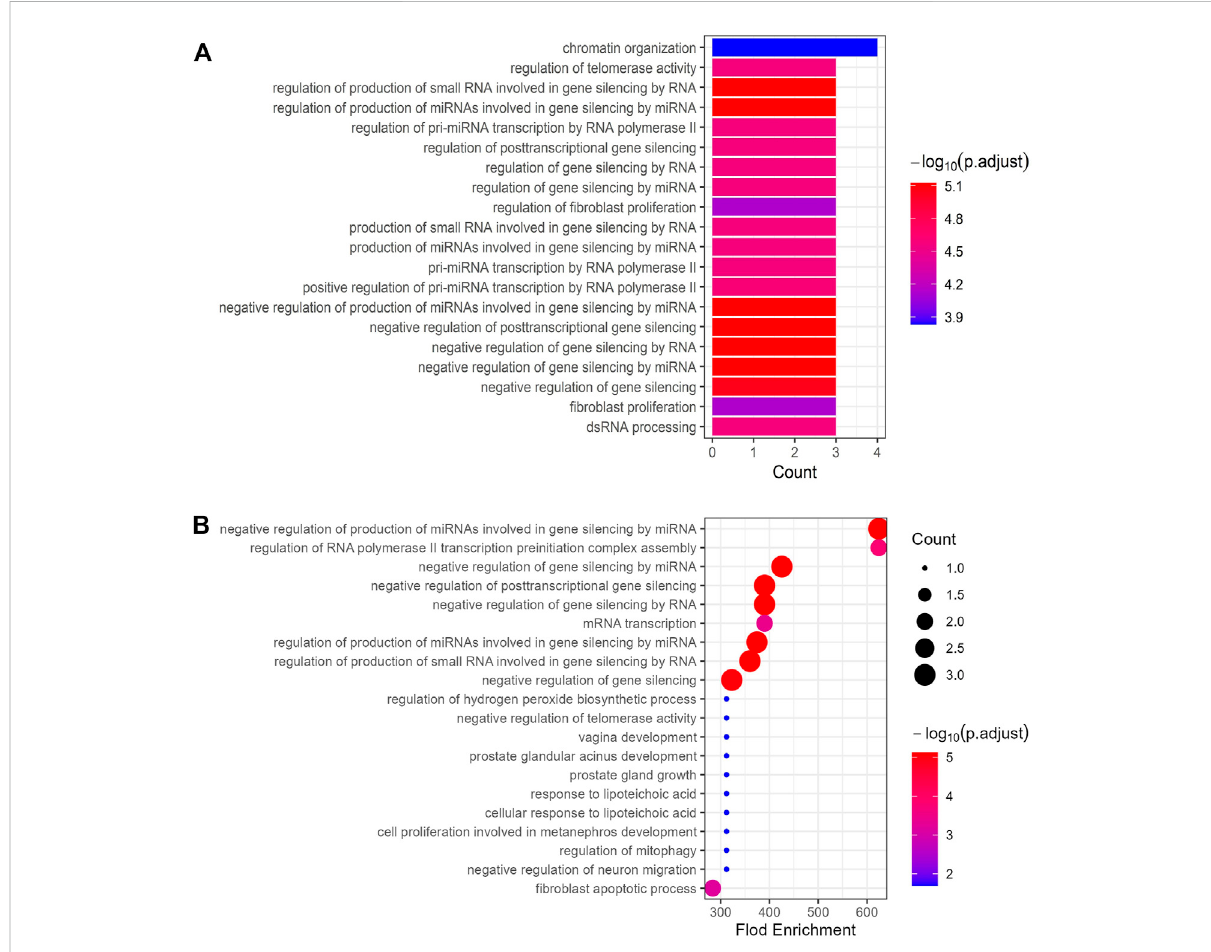
FIGURE 4 (A) Thebarplotshowsthehubgenesenrichedtop20BPitemsrankedbycounts. (B) Thebubblediagramshowsthehubgenesenrichedtop20 BP items ranked by fold